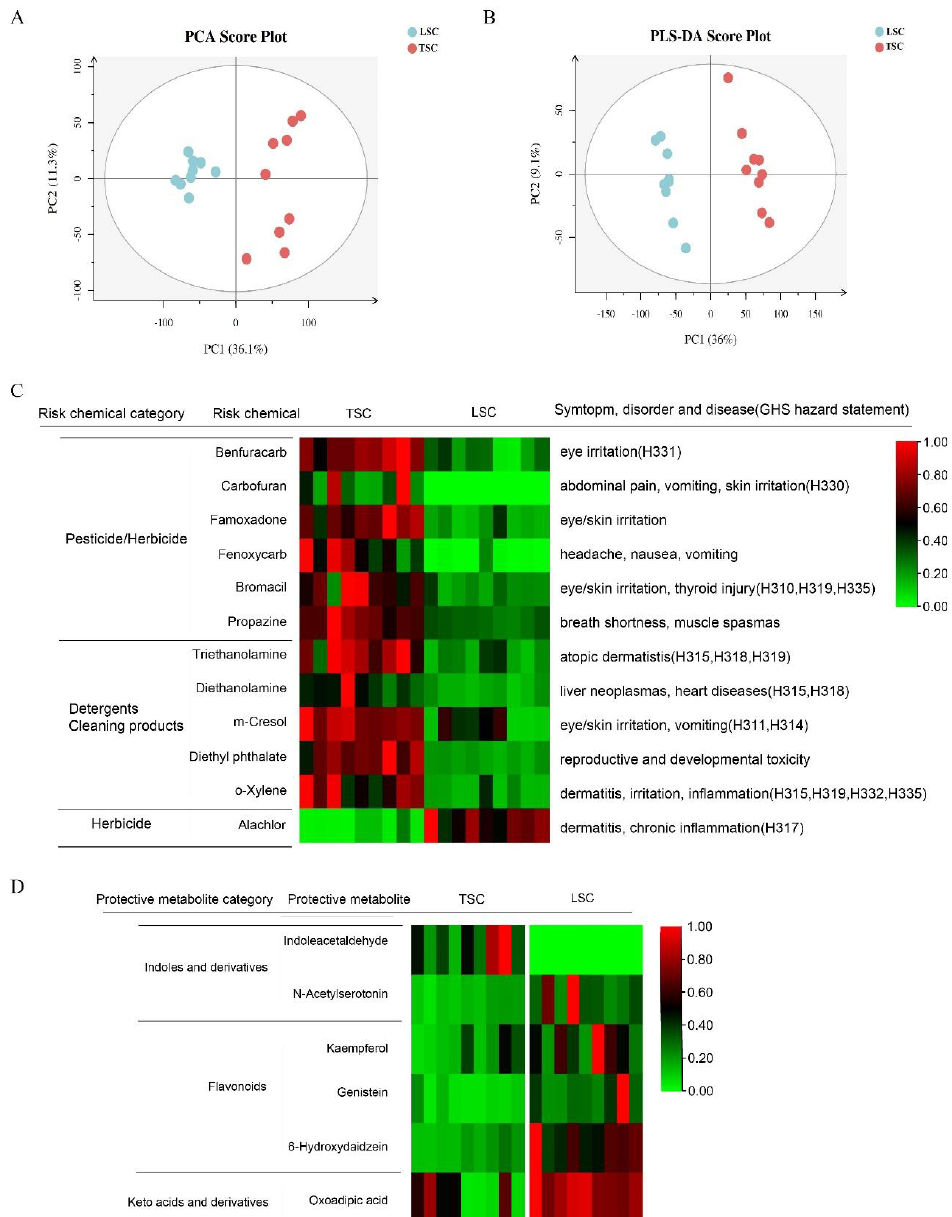
Figure 3. Variation of metabolites/chemicals in TSC and LSC. ( A ) Principal Component Analysis (PCA) and ( B ) Partial Least Squares Discriminant Analysis (PLS-DA) plots of aircraft metabo- lites/chemicals. ( C ) Risk chemicals and ( D ) protective metabolites enriched in TSC and LSC ( p < 0.01, FDR < 0.1 and fold change > 2). The relative abundance is displayed, with the highest value set as 1 in each line, and the remaining values calculated as ratios. The potential risk chemicals were defined as those associated with symptoms, disorders, and diseases according to Pubchem, or having GHS hazard codes between H300 and H336 (airway, skin, and eye irritation). These chemicals were mostly synthetic. Protective metabolites, including flavonoids, isoflavonoids, indoles, and keto ac- ids, were identified based on previous studies. Chemicals annotated as drugs were excluded from the table. H311: Toxic in contact with skin; H314: Causes severe skin burns and eye damage; H315: Causes skin irritation; H317: May cause an allergic skin reaction; H318: Causes serious eye damage; H319: Causes serious eye irritation; H330: Fatal if inhaled; H331: Toxic if inhaled; H332: Harmful if